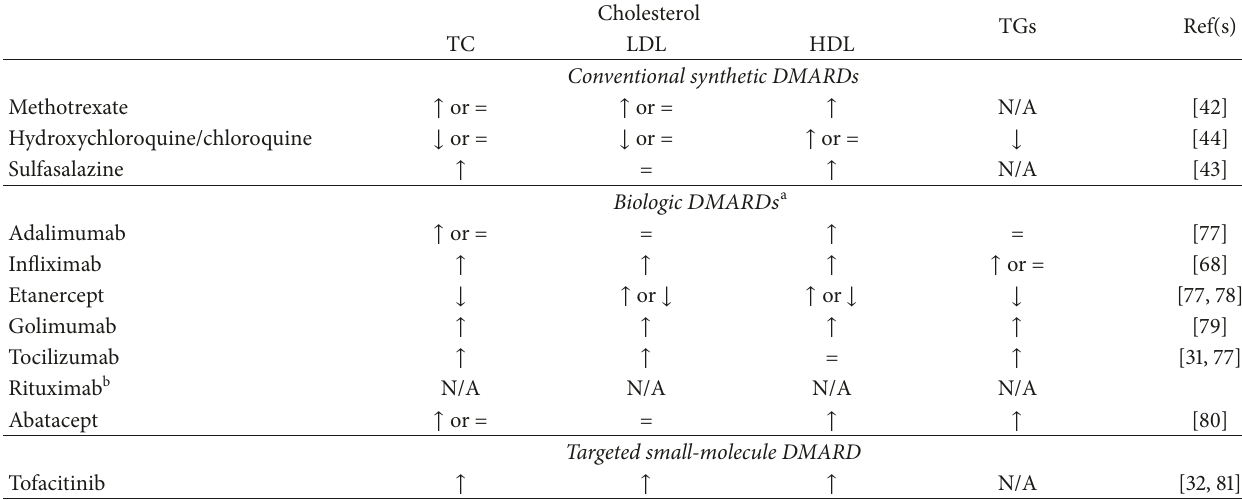
Table 2: Effects of nonbiologic and biologic DMARDs on lipid levels in patients with